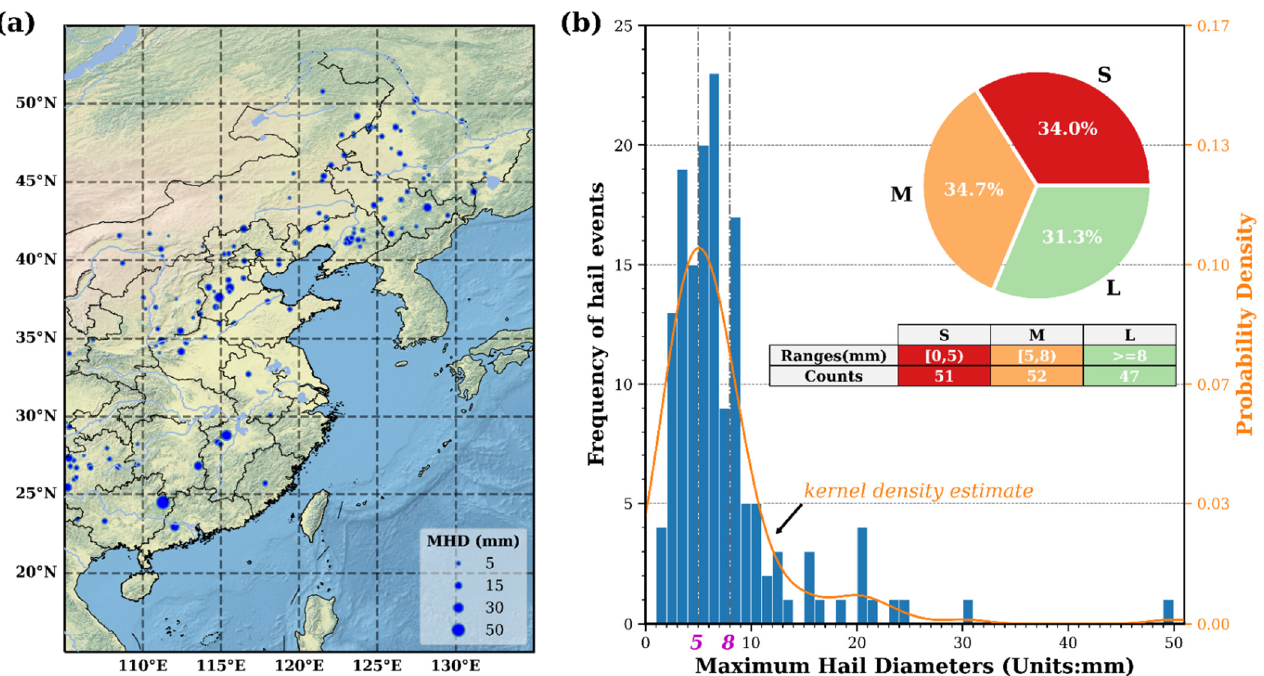
Figure 1. Distribution of hail events in this study: ( a ) The geographical spread of 150 hail events (blue dots) in the study region (15°–55°N, 105°–135°E). The sizes of dots represent observed maximum hail diameters (MHDs). The relief map is obtained from Natural Earth I with Shaded Relief and Water (1:10 m). ( b ) The histogram shows the frequency distribution of hail events with different MHDs. The curve displays the kernel density estimation of the histogram. The two dash-dot lines define the ranges of three size bins: S ( [ 0,5 mm ) ), M ( [ 5 mm,8 mm ) ), and L ( ≥ 8 mm ). The pie chart and table reveal the percentage and number of S-, M-, and L-size bins,